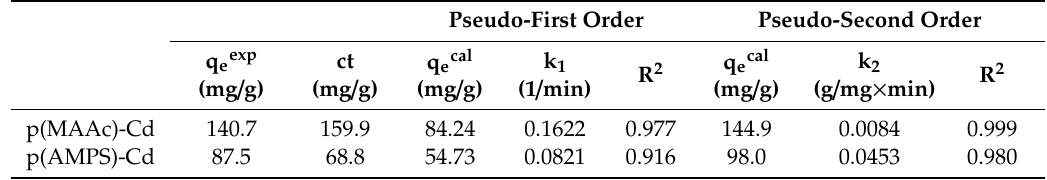
Table 2. Parameters of kinetic models for metal ions sorption by cryogels.